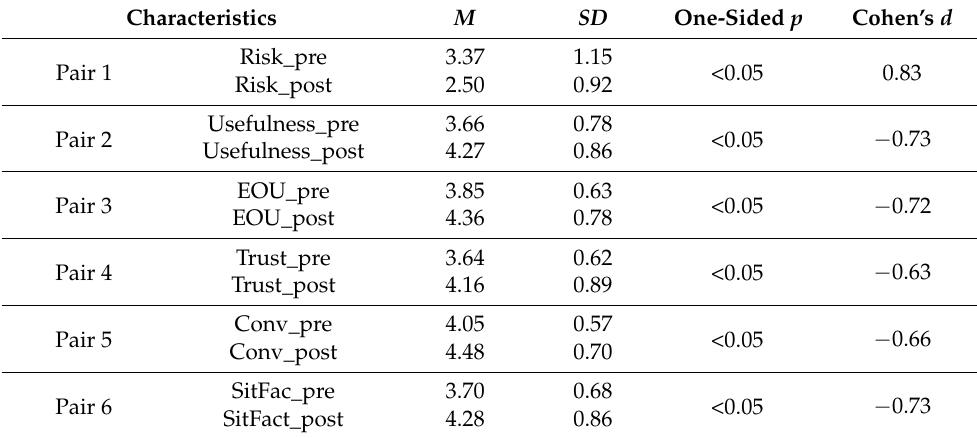
Table 5. T -tests analyses (Hypotheses